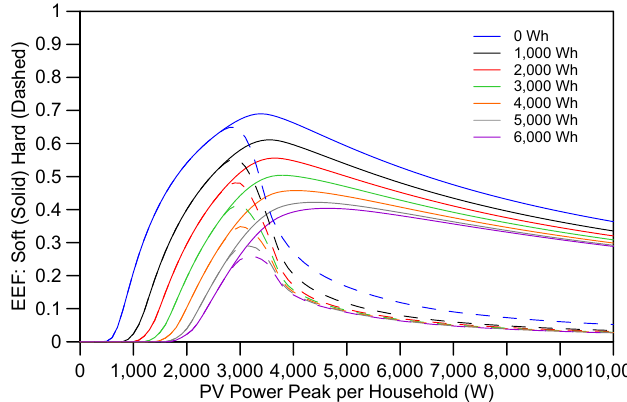
Figure 12. Annual EEF vs. installed PV power and storage capacity when soft curtailment (solid lines) or hard curtailment (dashed lines) are